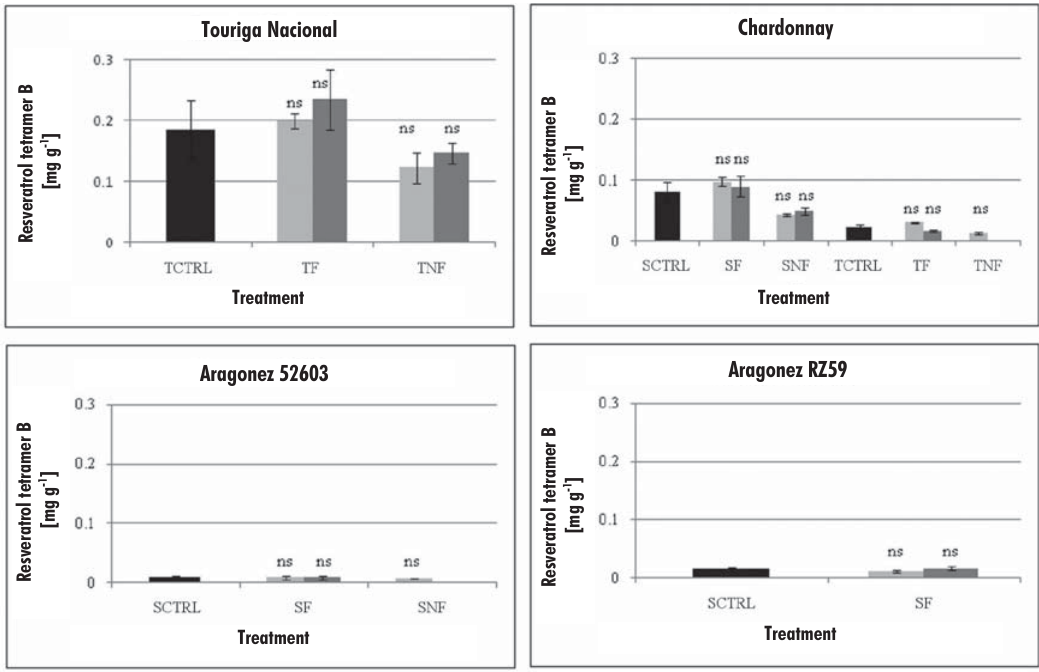
Fig. 6. Resveratrol tetramer B content in healthy and infected plants, from cv. Touriga Nacional, cv. Chardonnay, cv. Aragonez (52603) and cv. Aragonez (RZ59). Different tissue types are represented with infected plants: colonised trunk tissue (TF), uncolonised trunk tissue (TNF), colonised shoot tissue (SF) and uncolonised shoot tissue (SNF). Error bars represent standard deviation (n=4). Level of statistical signi fi cance is also indicated as *, P <0.05; **( P <0.01); ***, P <0.001; ns, non-signi fi cant. Control ( ¢ ), PH9 ( ¢ ), PH13 ( ¢ ). For control treatments, TCTRL refers to trunk control and SCTRL refers to shoot